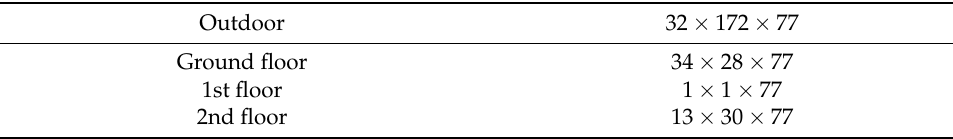
Figure 8. Radio maps for the four APs ( a ) AP_DD02-1, ( b ) AP-DD02-2, ( c ) AP-DD02-3 and ( d ) AP-DD02-4 on the second floor of the library. Table 6. Sizes of the radio map datacube arrays.